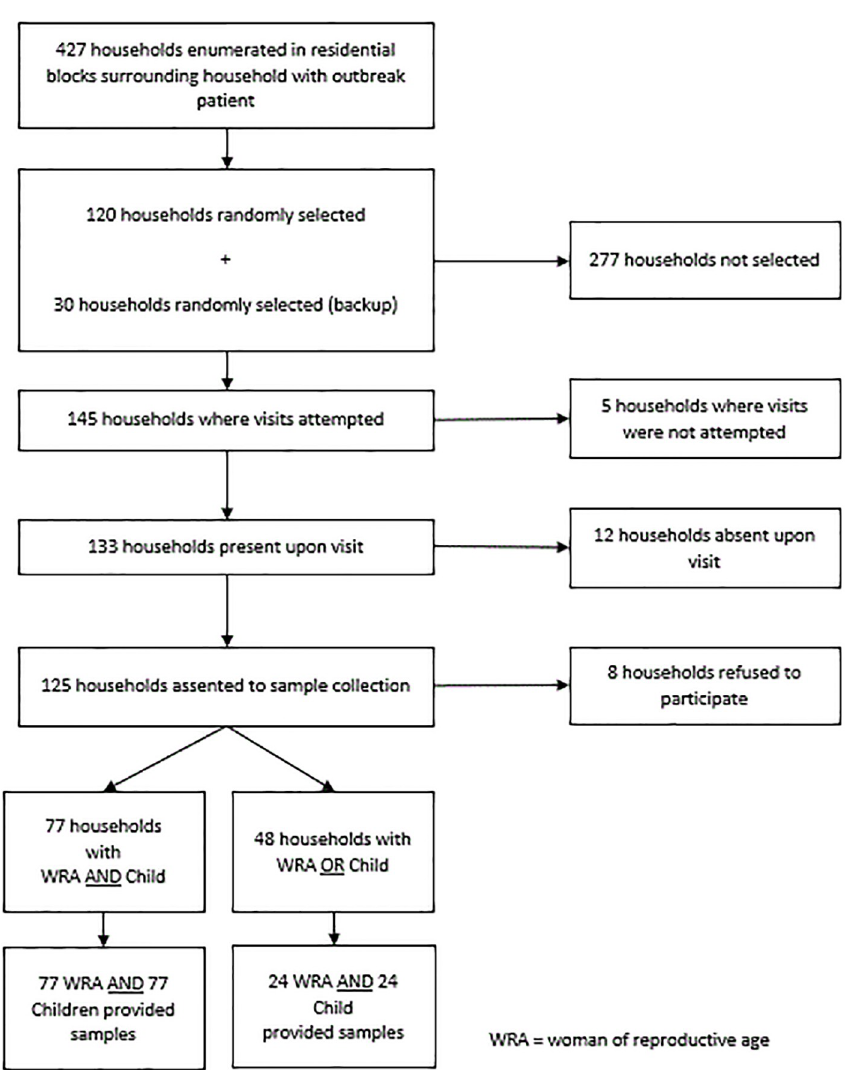
Fig 1. Serosurvey flowchart illustrating the number of households enumerated and study participants providing specimens.